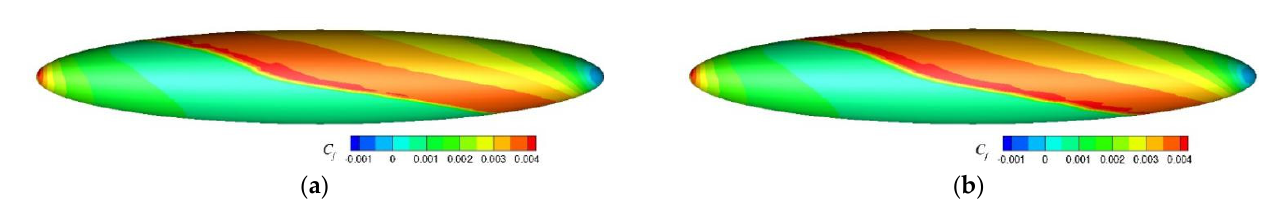
Figure 14. γ -Re θ t -CF SST-2003 transition model with present sustaining turbulence. ( a ) R T,FS =5.0. ( b ) R T,FS =10.0. Table 3. Drag coefficients for different